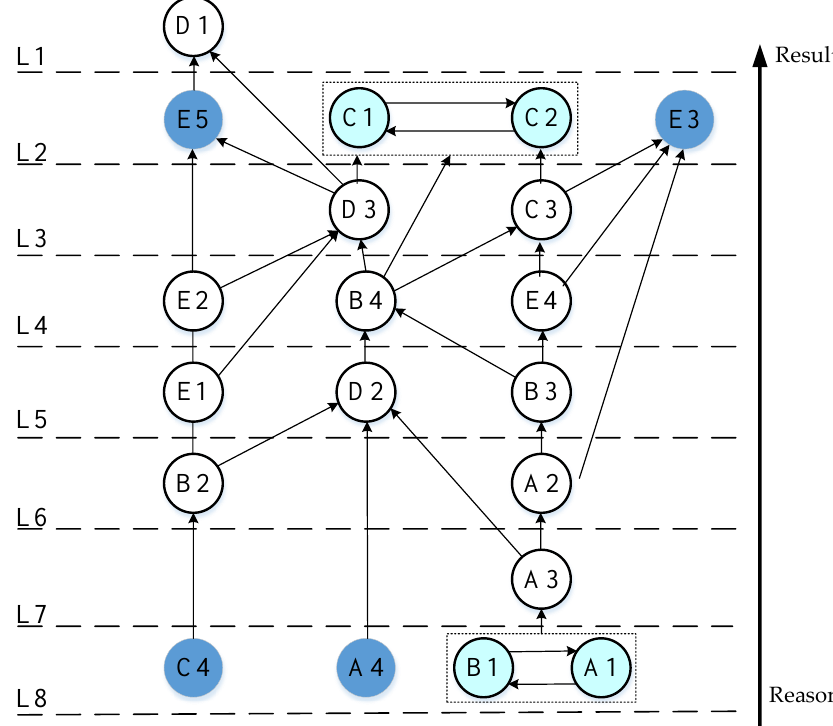
Figure 6. Directional topology hierarchy for DOWN-type cause priority. Based on the indicator relationships affecting the CTOS construction performance index system, the UP-type and DOWN-type hierarchical topology diagrams of eight